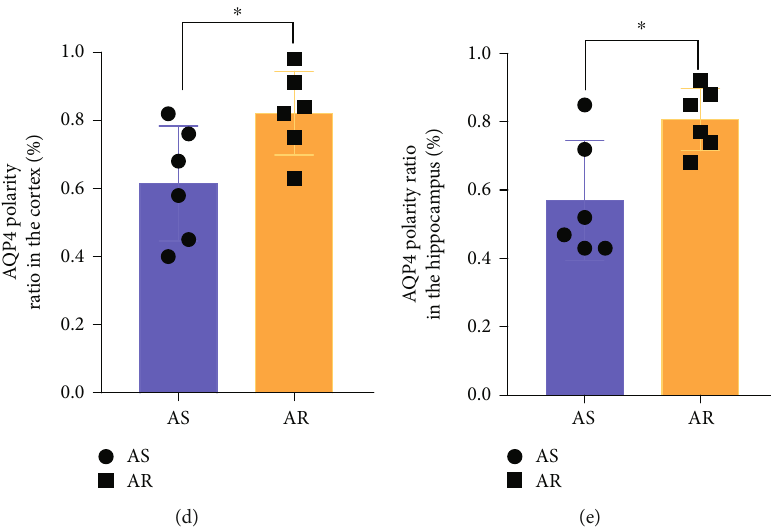
Figure 6: CTBS improved AQP4 polarization in APP/PS1 mice. (a) Immuno fl uorescent staining of AQP4 in the cortex and hippocampus (200 × , scale bar: 100 μ m). (b) Statistical analysis of relative AQP4 expression levels in the cortex. (c) Statistical analysis of relative AQP4 expression levels in the hippocampus. (d) Statistical analysis of relative perivascular polarization of AQP4 in the cortex. (e) Statistical analysis of relative perivascular polarization of AQP4 in the hippocampus. Data are presented as the mean ± SD ( n = 6 mice per group, unpaired t -test for comparing two individual groups; ∗ P < 0 : 05 , ∗∗ P < 0 : 01 , ∗∗∗ P < 0 : 001 , ∗∗∗∗ P < 0 : 0001